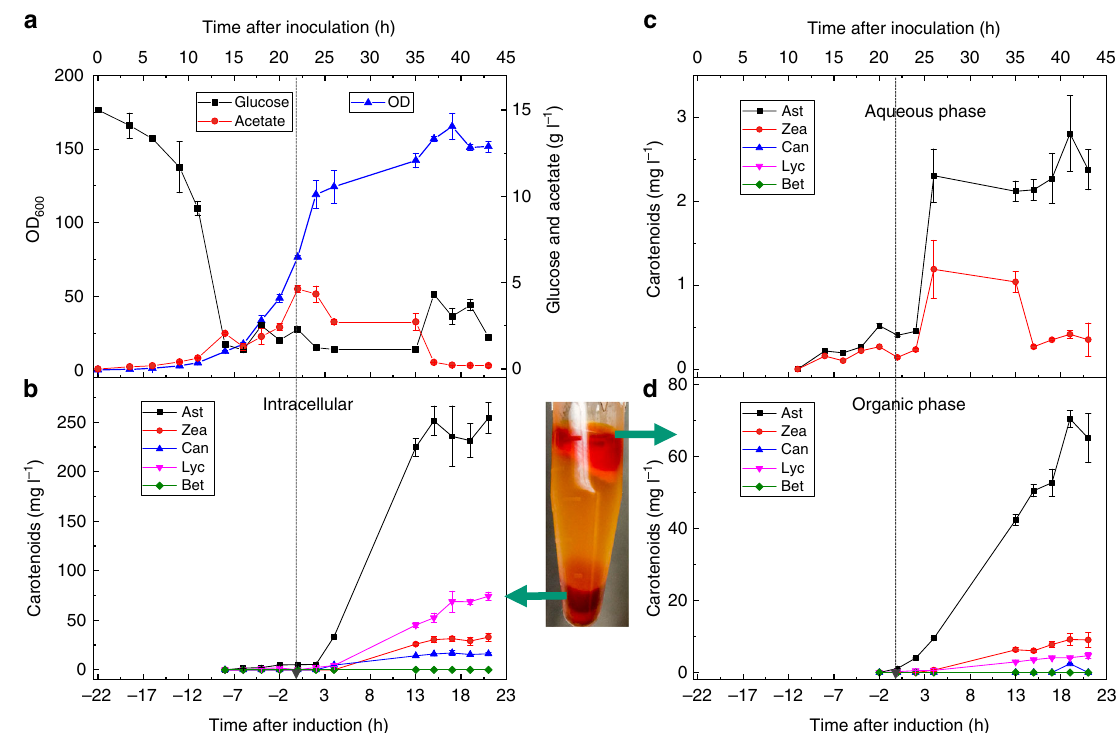
Fig. 7 Simultaneous fermentation and extraction of astaxanthin. a Time-course pro fi les of OD, glucose and acetate. b Time-course pro fi les of intracellular carotenoid production. c Time-course pro fi les of aqueous carotenoid production. d Time-course pro fi les of organic carotenoid production. The dashed arrow refers to the induction time. Error bars, mean ± s.d., n =